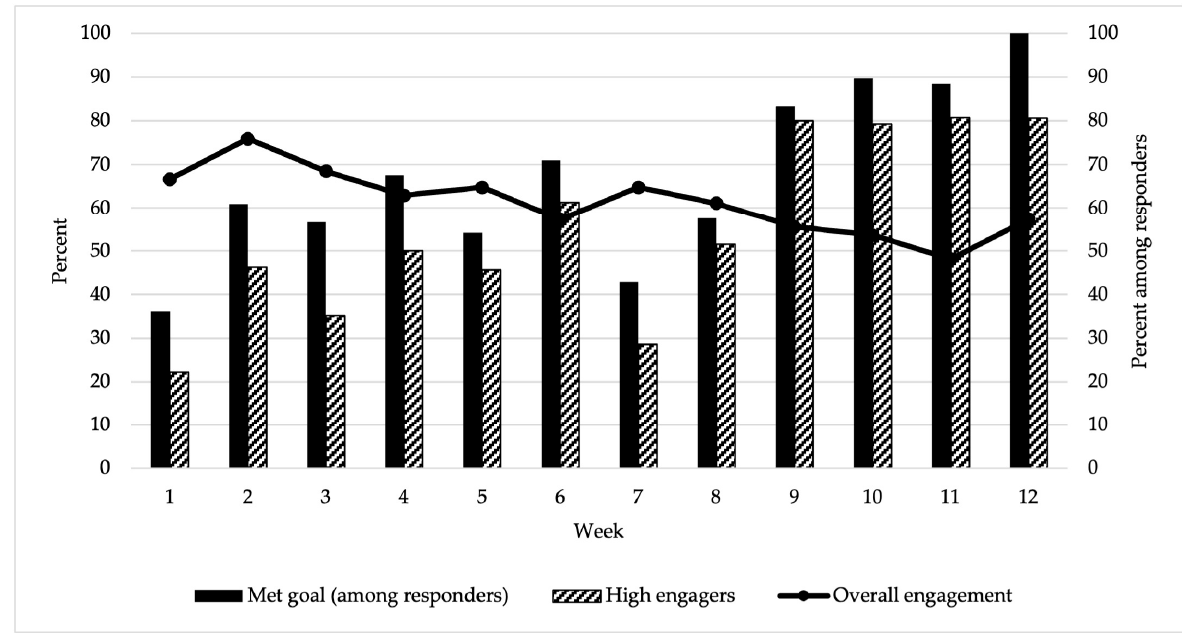
Figure 2. Engagement across the 12-week pilot (n = 54). The primary axis represents overall engagement across the 12-week pilot as noted by the line graph; the secondary axis represents the percent who met their goal and the percent who were high engagers (responded to 80% or more of texts) among those who responded to the texts for each week across the 12-week pilot as represented by the bar graph.